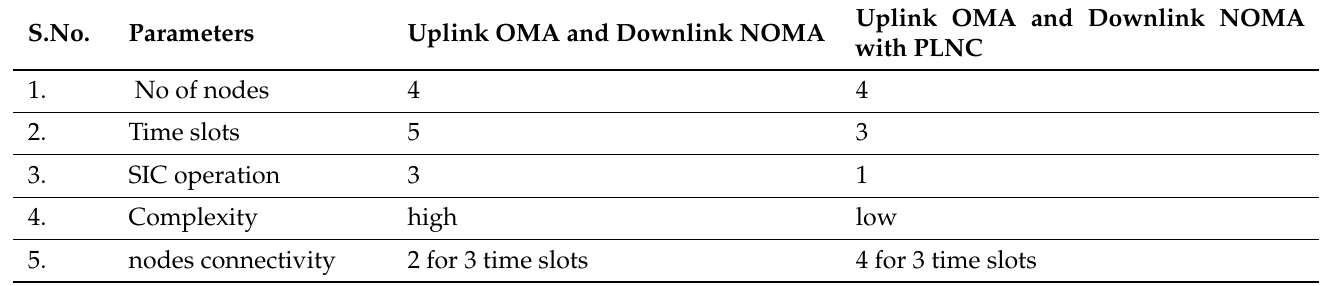
Table 1. Comparison of NOMA and NOMA with